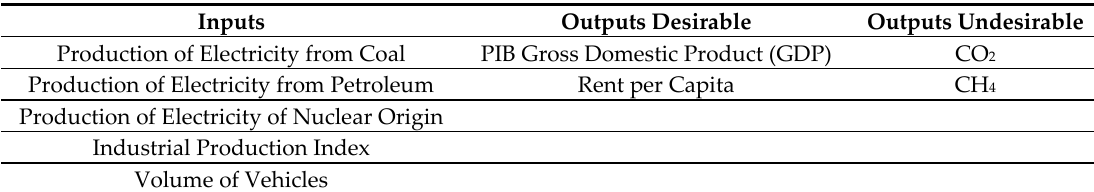
Table 1. List of inputs, desirable outputs and undesirable outputs selected for our